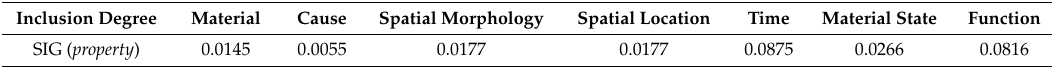
Table 5. Weights of properties in the decision